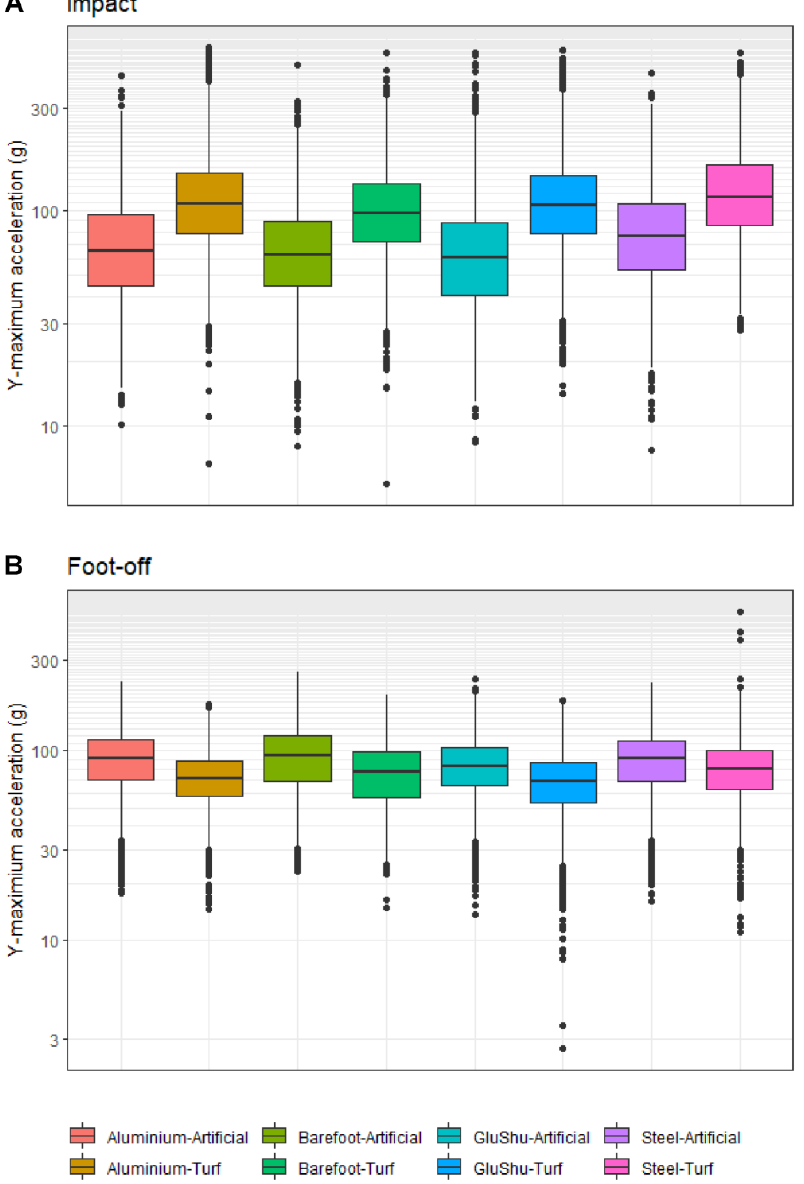
Figure 3. ( A ) Boxplots illustrating the impact accelerations for the y-maximum parameter across shoe – surface combinations. ( B ) Boxplots illustrating the foot-off accelerations for the y-maximum parameter across shoe – surface combinations. Data are pooled across limbs in each case. Considering all six acceleration axes together in the individual limb datasets, the ab- solute means of EMM accelerations on the artificial surface ranged from 36.4 ± 15.7 g ( n =